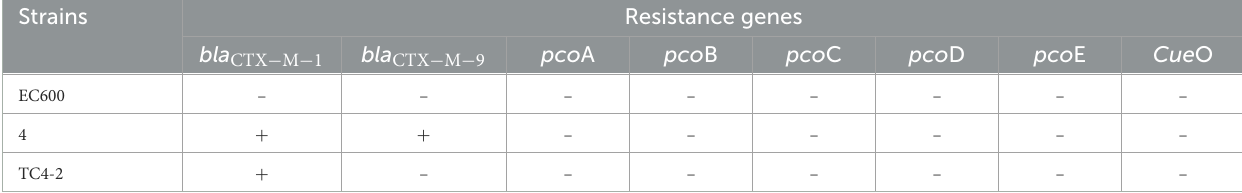
TABLE 2 Resistant genes in donor and recipient E. coli strains, and the corresponding transconjugant.